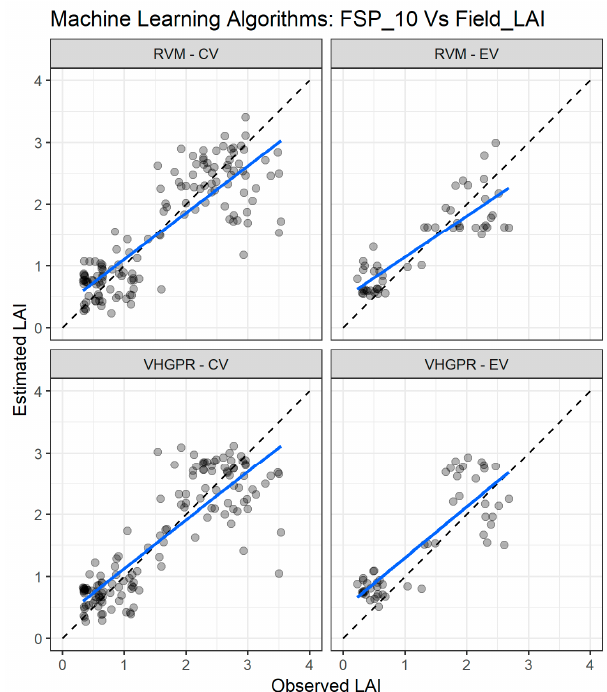
Figure 9. Comparisons of the LAI measured and estimated with the two best performing machine learning regression algorithms (MLRA) using the field spectra resampled to 10 nm (FSP_10). CV—cross validation, EV—external validation. RVM—relevance vector machine; VH-GPR—VH. Gaussian processes regression. The full line depicts the linear regression and the black dashed line the linear regression through